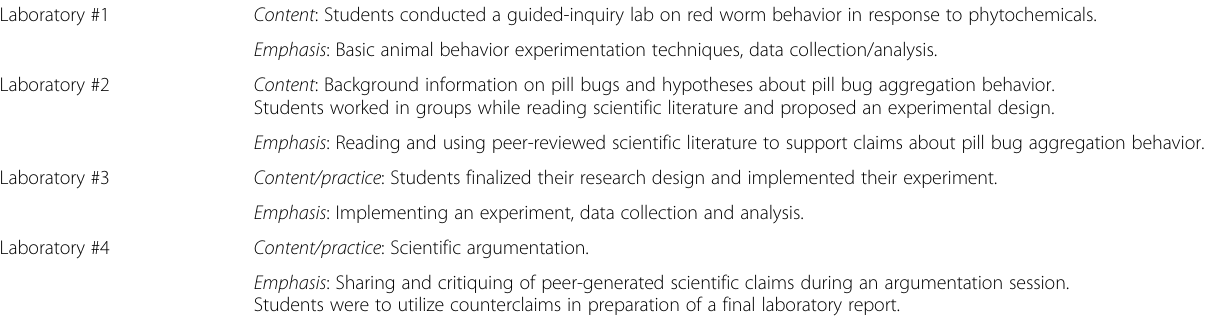
Table 1 Animal behavior (pill bug) laboratory scope and sequence Laboratory #1 Content : Students conducted a guided-inquiry lab on red worm behavior in response to phytochemicals. Emphasis : Basic animal behavior experimentation techniques, data collection/analysis. Laboratory #2 Content : Background information on pill bugs and hypotheses about pill bug aggregation behavior. Students worked in groups while reading scientific literature and proposed an experimental design. Emphasis : Reading and using peer-reviewed scientific literature to support claims about pill bug aggregation behavior. Laboratory #3 Content/practice : Students finalized their research design and implemented their experiment. Emphasis : Implementing an experiment, data collection and analysis. Laboratory #4 Content/practice : Scientific